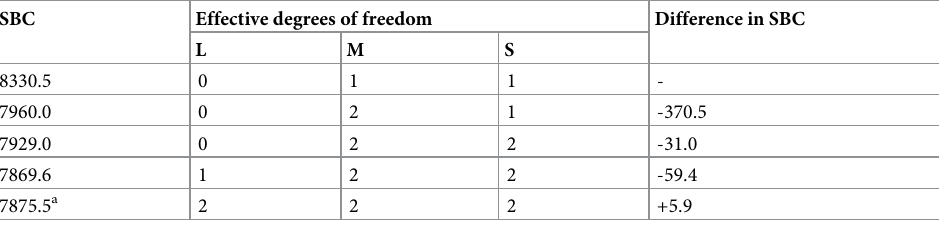
Table 3. Sequential optimisation process for the expressive one word picture vocabulary test using sampling weights (n = 1,027).